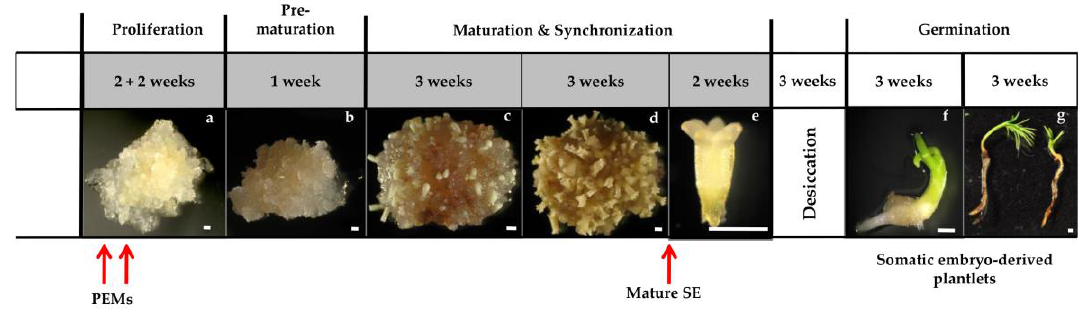
Figure 1. Overview of sampling during the somatic embryogenesis process in Norway spruce PEMs were sampled from experimental media after four and ten days (red arrows). Samples were taken after six weeks on maturation media (red arrow).